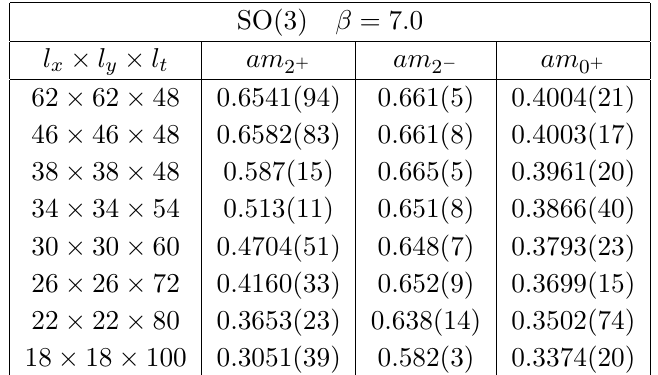
Table 5 . Lightest J P = 2 + ; 2 (cid:0) ; 0 + glueball masses on various l x (cid:2) l y spatial lattice volumes. In SO(3) at an inverse bare coupling (cid:12) = 6 =ag 2 = 7 :